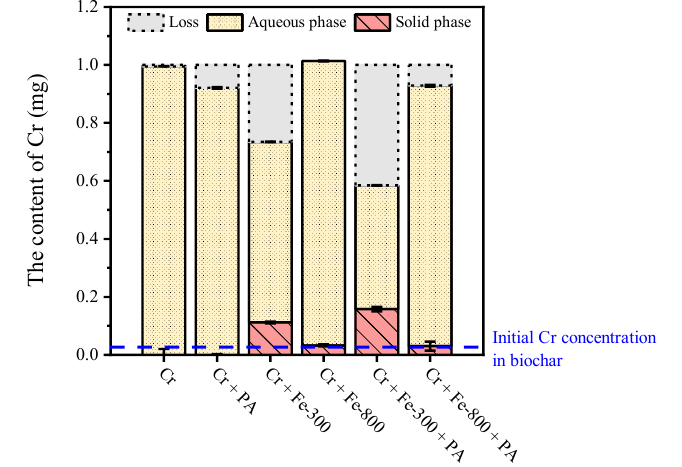
Figure 2. The mass balance of chromium (total volume of 100 mL). Noted: “Loss” means the loss of chromium compared to initial total chromium.